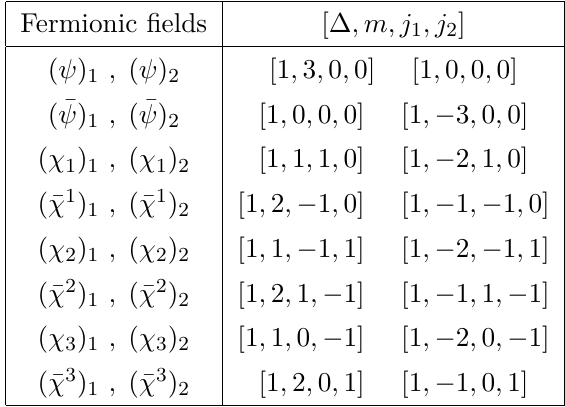
Table 3 . Quantum number assignments to fermionic matter fields of the ABJ(M) theory defined in eq.